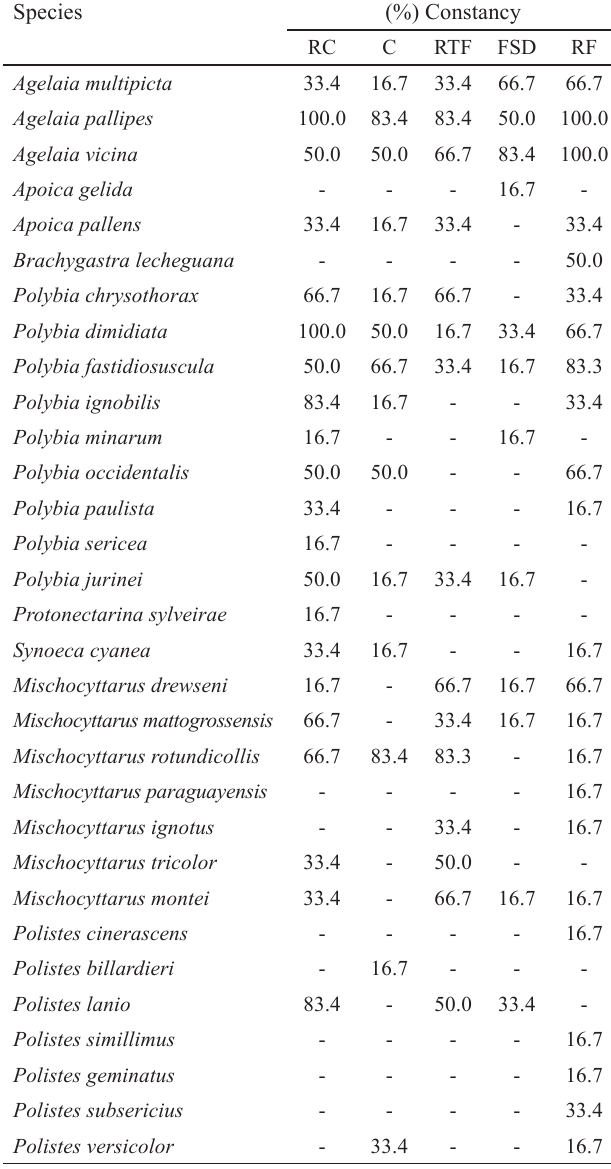
Table 3 . Constancy (C) of social wasp species in five study sites in São Paulo, Brazil, classified as follows: constant species (C ≥ 50%); accessory species (25% ≤ C < 50%); incidental species (C < 25%). RC: Regenerating Cerrado; C: Cerradão; RTF: Restored forest; FSD: Semideciduous forest; RF: Riparian